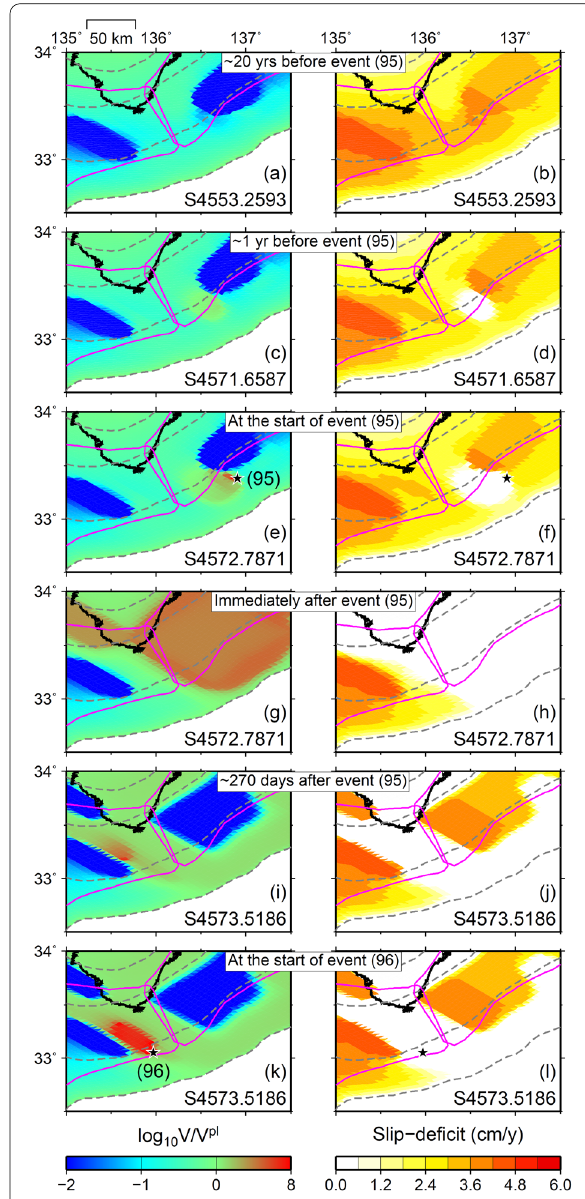
Fig. 10 Distributions of (left) slip velocity and (right) slip-deficit rate on the plate interface southeast of Cape Shiono at six points in time before and during the quasi-Hoei-type earthquake (events 95–97) which followed the Showa-type earthquake of events 92 and 93. Slip velocity is normalized by the plate convergence